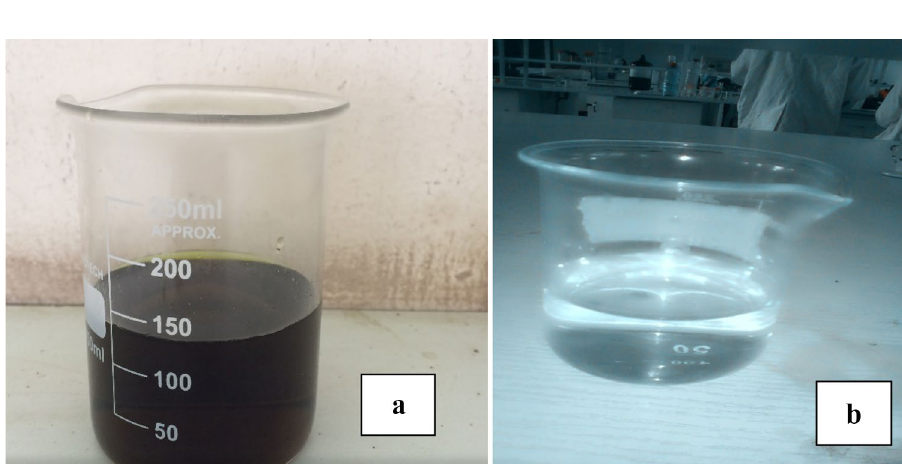
Fig. 5 a Electroplating waste water, b treated electroplating